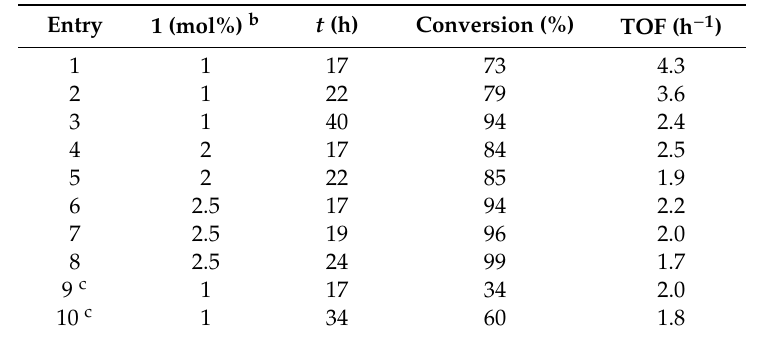
Table 9. Hydration of benzonitrile at 25 ◦ C catalyzed by [RhCl(cod)(IMes)] ( 1 ) with equimolar amounts of NaOH a